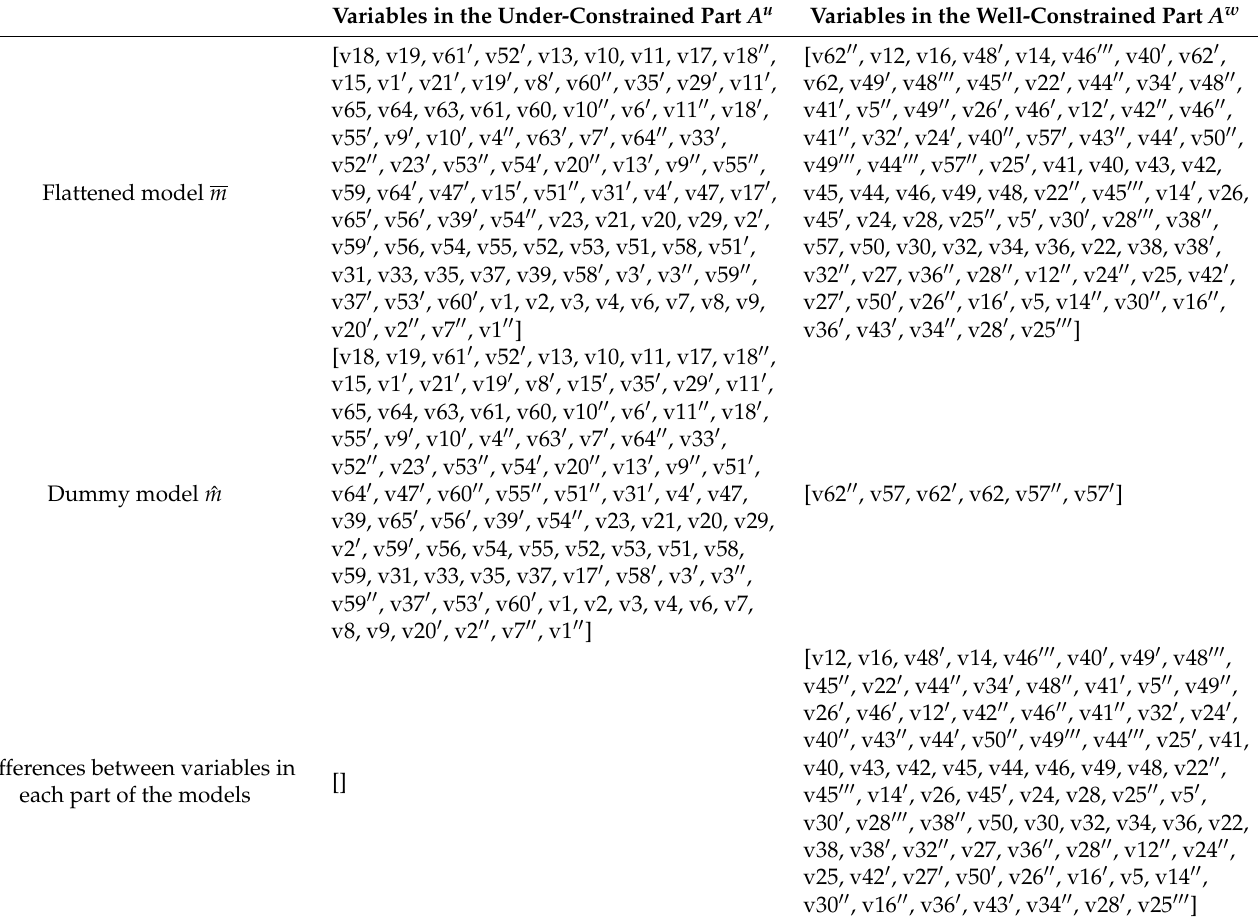
Table 2. Variables in different parts of the dummy model and the flattened